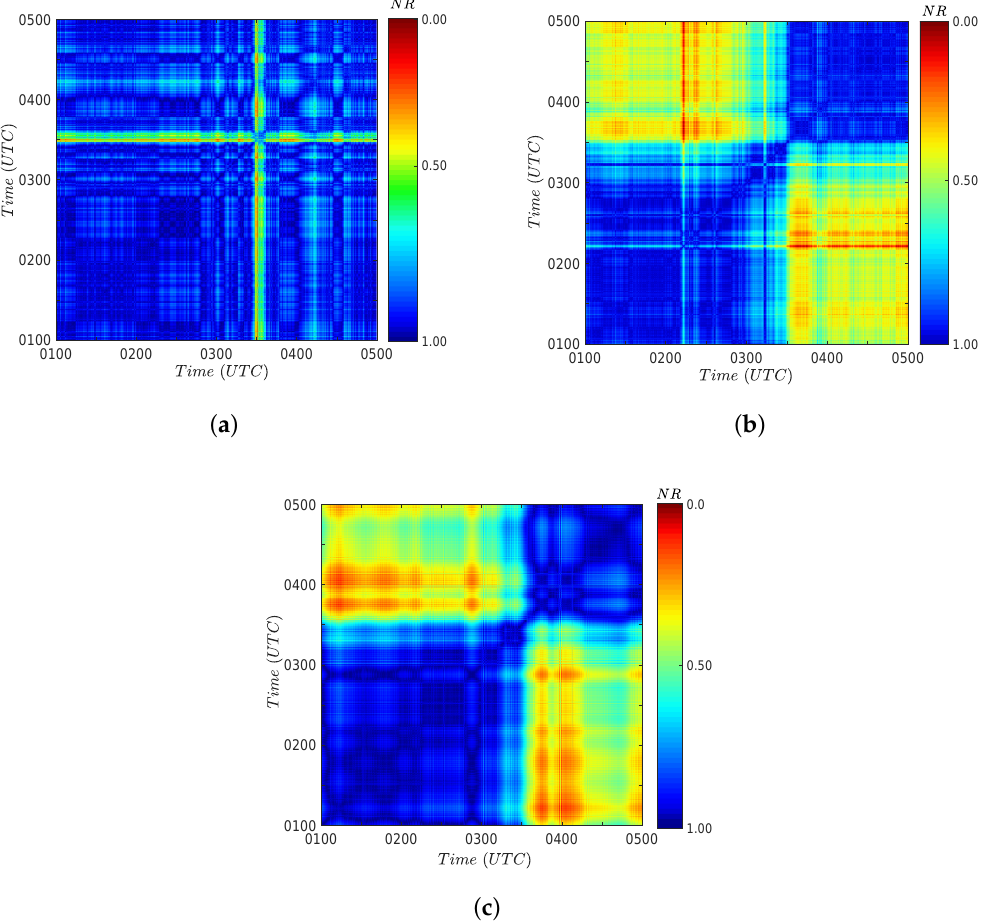
Figure 5. Recurrence plots (RP) for turbulent time series during 13 April 2014: ( a ) horizontal wind speed V (m s − 1 ), ( b ) equivalent potential temperature θ E (K) and ( c ) O 3 -mixing ratio (ppb). The vertical bars represent the Recurrence in the form NR = RP / ( RP ) max corresponding to each one of the three